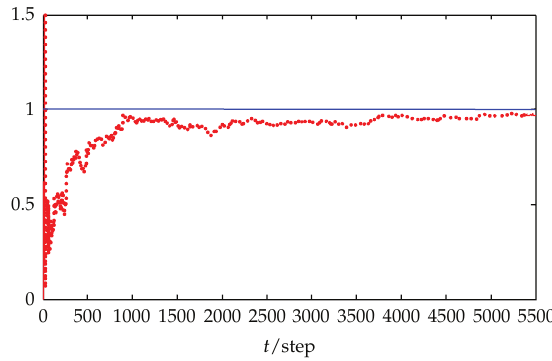
(cid:11) Q w (cid:5) t (cid:6)